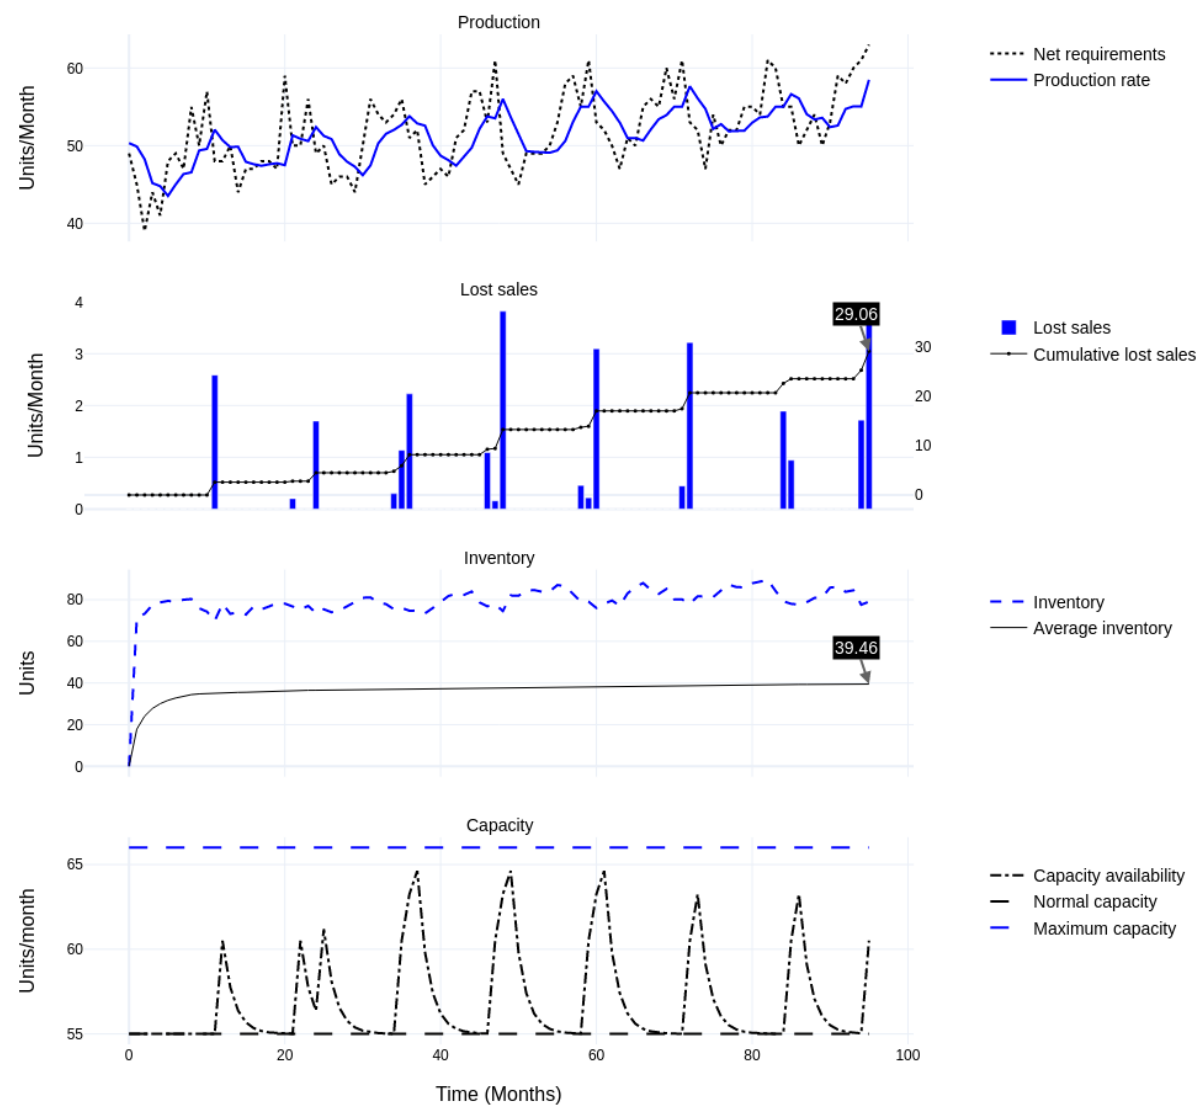
Figure 11. Whole-model simulation results: heuristics with discretionary capacity; quick ramp-up and ramp-down.